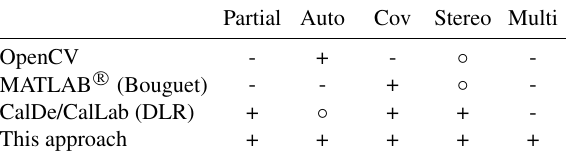
Table 1: Comparison of different calibration approaches in terms of their capabilities to handle a partially visible board (Partial), no need of manual interactions (Auto), output of covariance matrix (Cov), and usability for stereo systems (Stereo) or multi camera systems (Multi). Details are found in Section